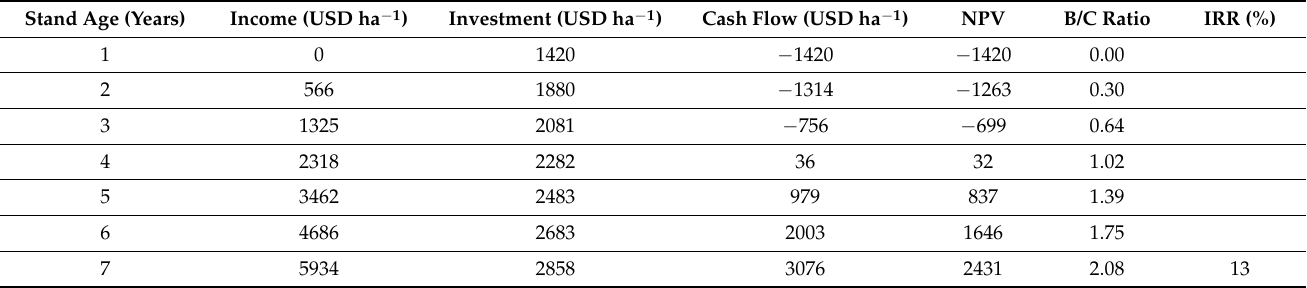
Table 5. Summary of annual income, investment, and cash flow and the results of economic feasibility analysis for Acacia hybrid plantations in southern Vietnam. NPV is net present value, B/C Ratio is benefit-cost ratio, and IRR means internal rate of